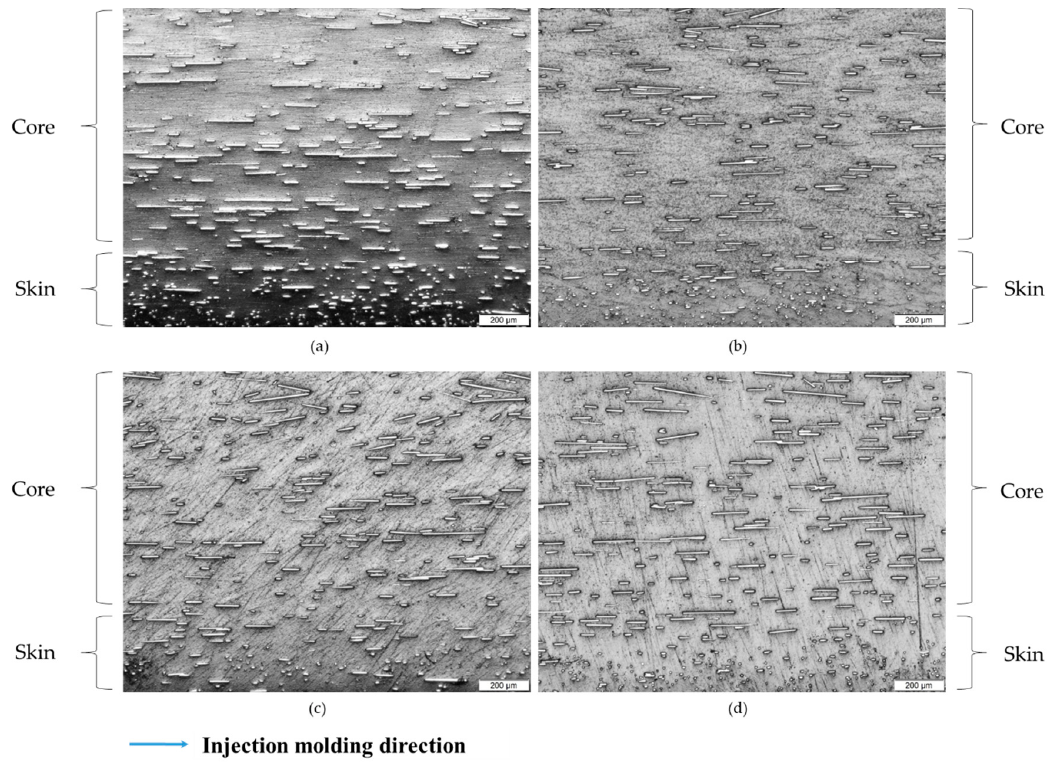
Figure 4. Optical microscope images of longitudinal section surfaces of ( a ) PP / 15SCF, ( b ) PP / 10SCF / 5nTiO 2 , ( c ) PP / 10SCF / 5GNP, and ( d ) PP / 10SCF / 2.5GNP / 2.5nTiO 2 composites.